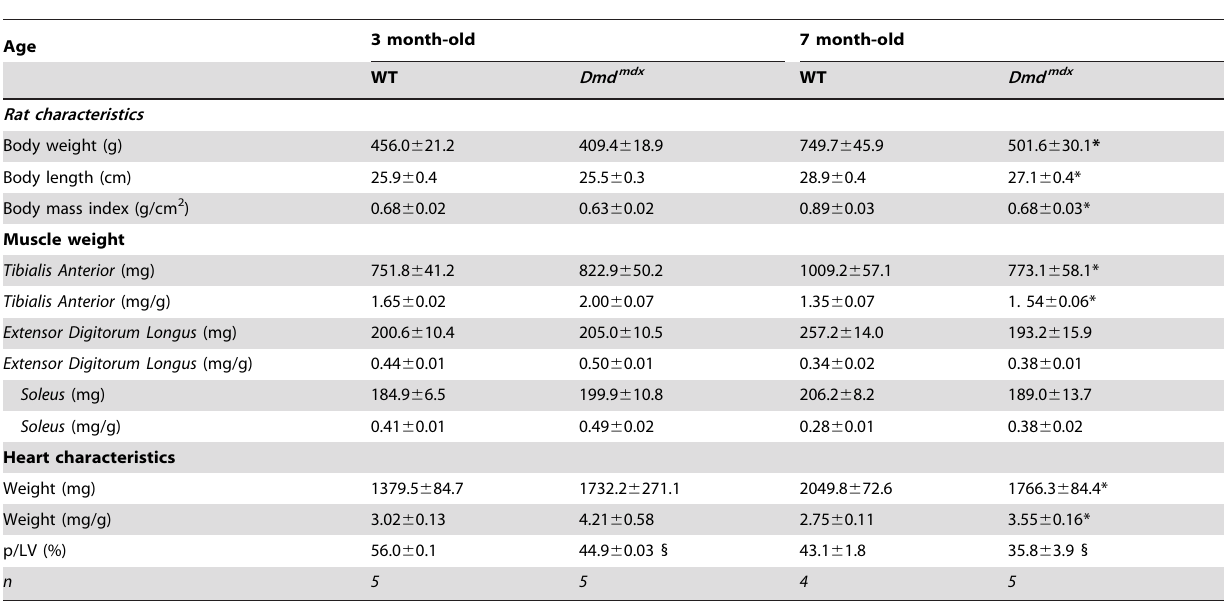
Table 1. Rat weight and size as well as isolated muscles weight and heart characteristics of Dmd mdx male